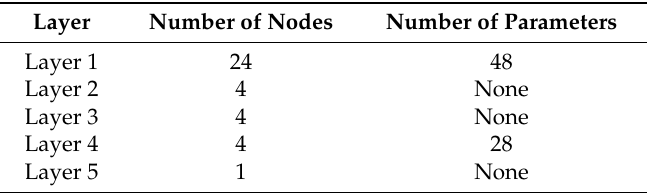
Table 3. The structure of the utilized